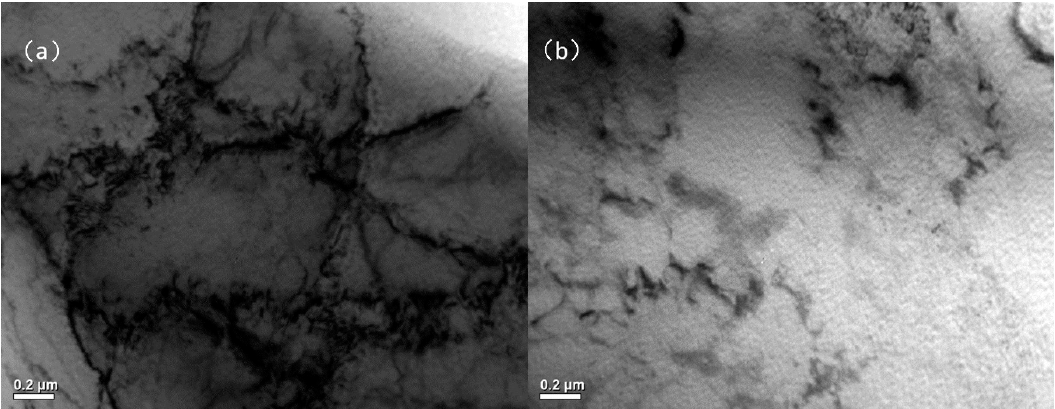
Figure 6. Transmission electron microscopy micrographs of the heat-treated AISI 1008 steel before ( a ) and after ( b ) heat treatment. The dislocation forests have been reduced after heat treatment for t (cid:2925) = 3s with the inductive heater at d = 0.2mm.